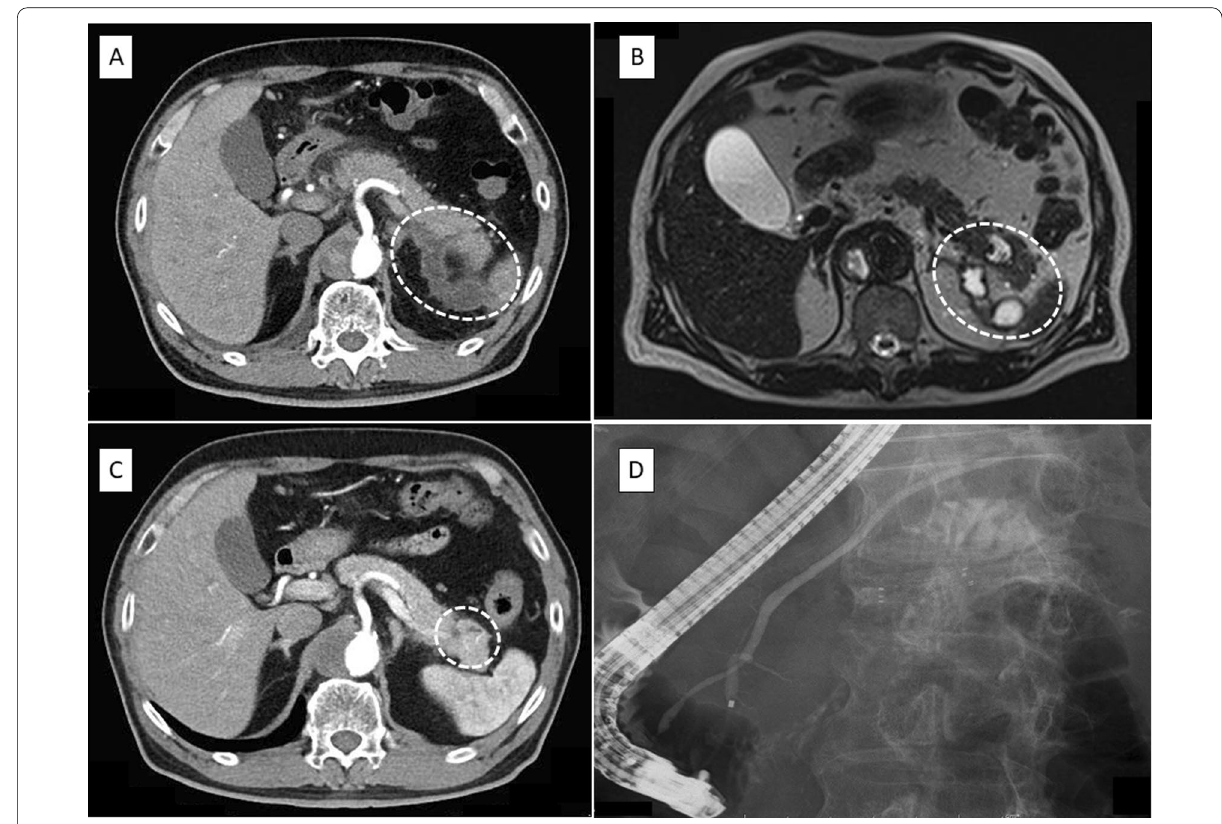
Fig. 1 A Contrast-enhanced computed tomography showing fluid collection around the pancreas with pseudocyst (circle). B Magnetic resonance cholangiopancreatography showing pseudocyst without intraductal papillary mucinous neoplasm (circle). C Contrast-enhanced computed tomography showing shrinkage of the pseudocyst with slightly dilated distal pancreas duct (circle). D Endoscopic retrograde cholangiopancreatography showing no stenosis and dilatation of the pancreatic